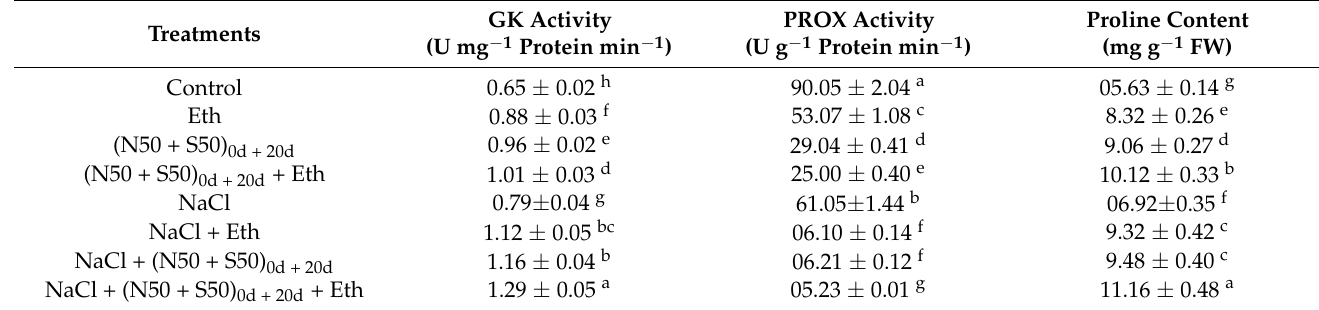
Table 4. The activity of glutamyl kinase (GK), proline oxidase (PROX), and the content of proline in mustard plants at 40 DAS. Plants were raised with split doses of N and S (50 + 50 mg kg − 1 soil) at sowing time (0 DAS) and at 20 DAS, and were treated with 200 µ L L − 1 ethephon (Eth) in the absence or presence of 100 mM NaCl. Values are presented as means ± SE ( n = 4). Data followed by the same letter are not significantly different by LSD test at p < 0.05. DAS: days after